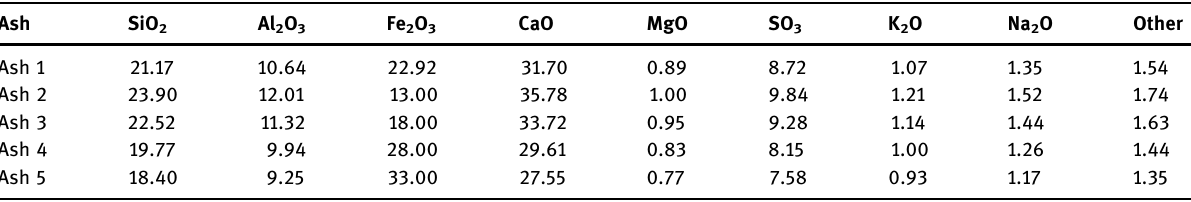
Table 4: Ash composition of di ff erent Fe 2 O 3 contents ( wt%